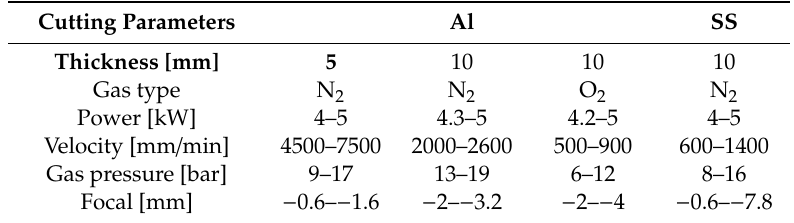
Table 2. Ranges of laser cutting parameters tested during the